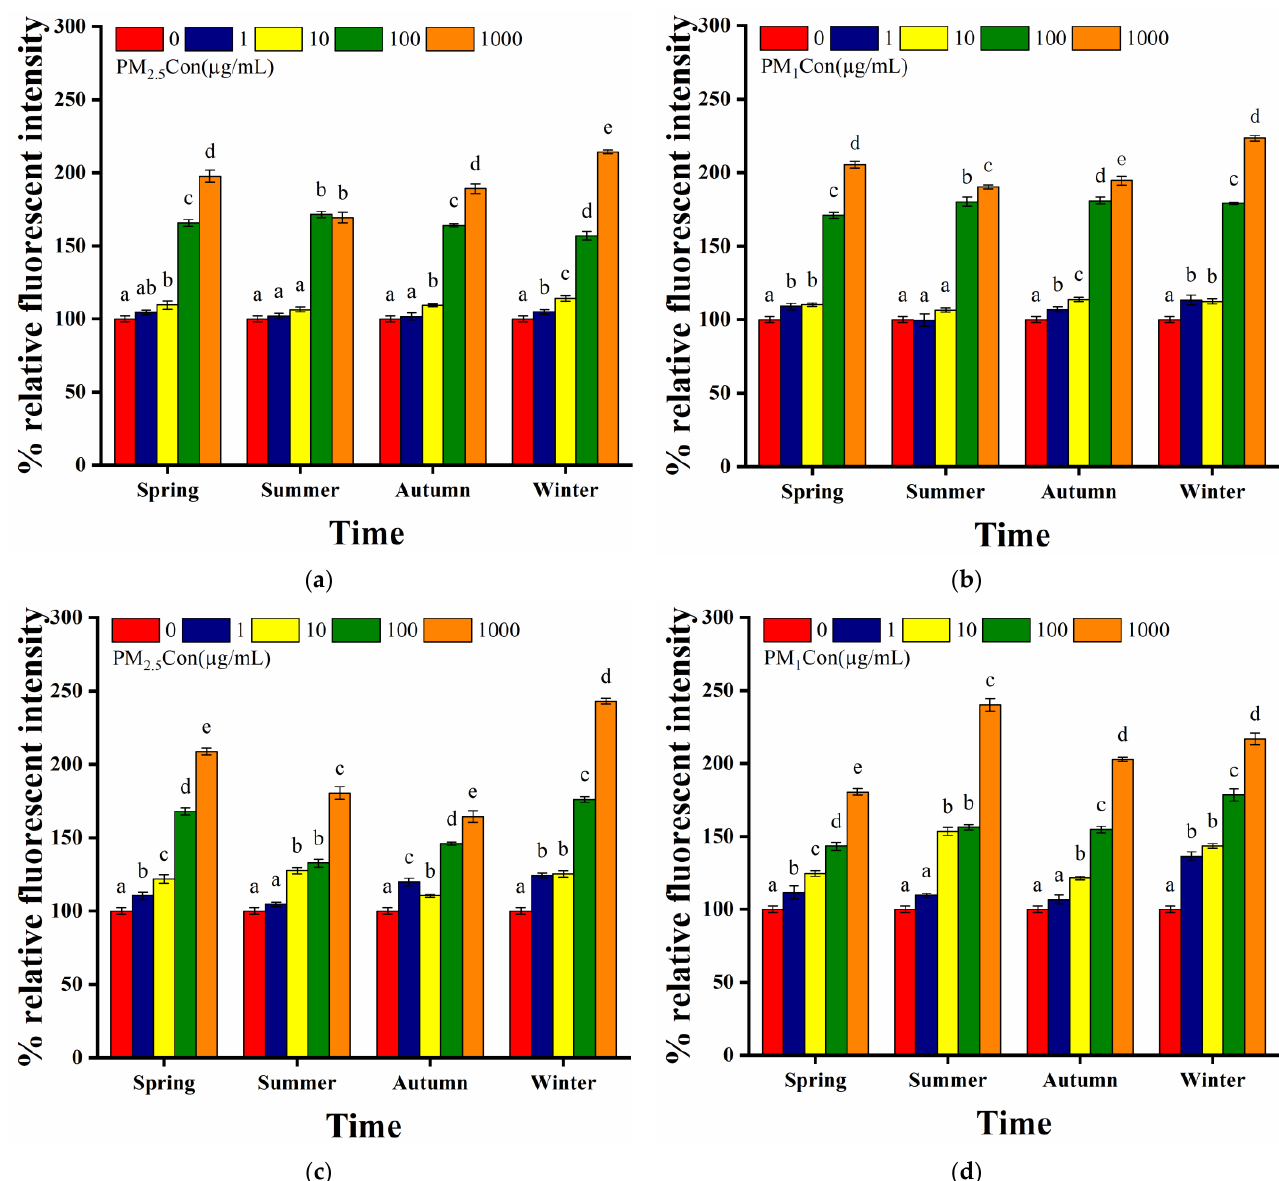
Figure 4. Effect of different seasons of PM exposure on nematode intestinal autofluorescence and ROS levels: ( a ) intestinal autofluorescence levels of nematodes exposed to 1, 10, 100 and 1000 µg/mL of PM 2.5 in four seasons compared to the control; ( b ) intestinal autofluorescence levels of nematodes exposed to 1, 10, 100 and 1000 µg/mL of PM 1 in four seasons compared to the control; ( c ) ROS levels of nematodes exposed to 1, 10, 100 and 1000 µg/mL of PM 2.5 in four seasons compared to the control; ( d ) ROS levels of nematodes exposed to 1, 10, 100 and 1000 µg/mL of PM 1 in four seasons compared to the control. L4 stage larvae were selected for 24 h acute exposure. Different letters (a, b, c, d, e) indicate significant differences among the five PM treatments in each season ( p < 0.05). Bars represent means ± SEM.